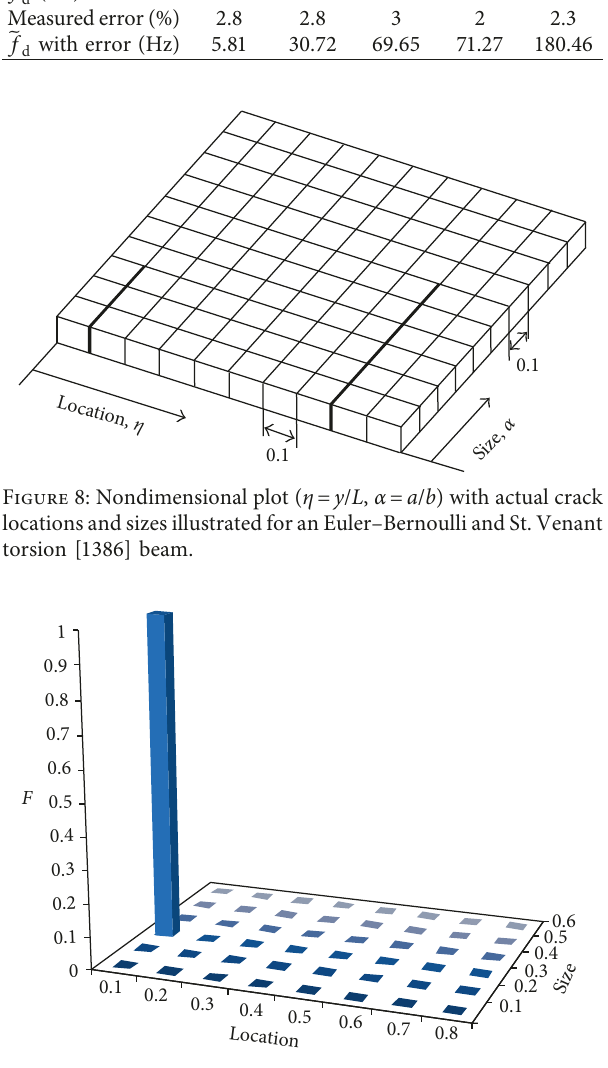
Figure 9: Damage index for the first crack of a multicracked [1386] composite beam with no measured